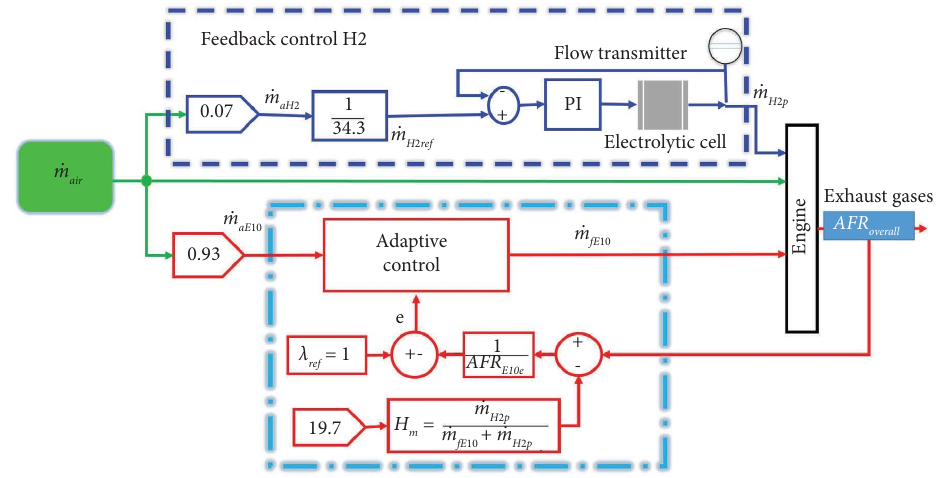
Figure 2: AFR control